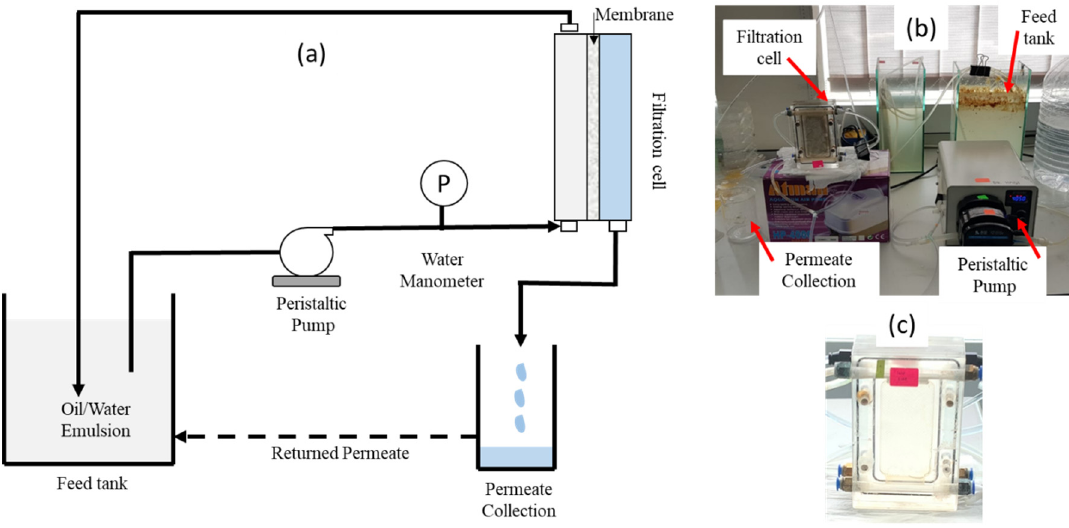
Figure 1. ( a ) Illustration and ( b ) pictures of the filtration set-up ( c ) and picture of the home-made filtration cell.